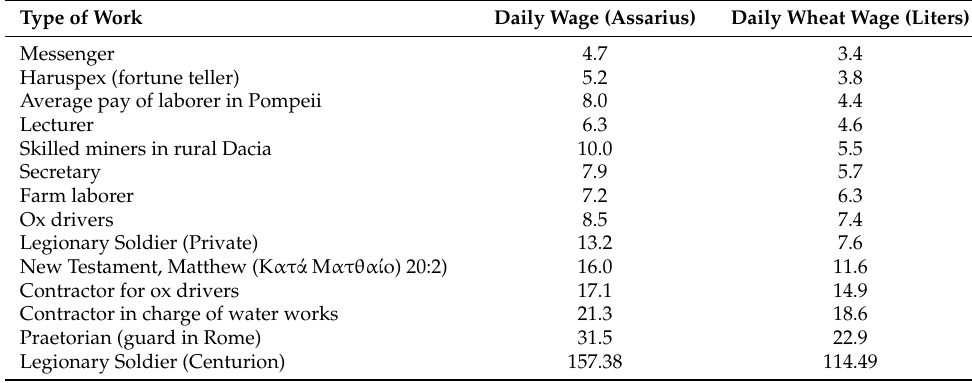
Table 2. Daily wages in asses and wheat in Rome Empire 1st c. AD [105,106,113–122]. Type of Work Daily Wage (Assarius) Daily Wheat Wage (Liters) Messenger